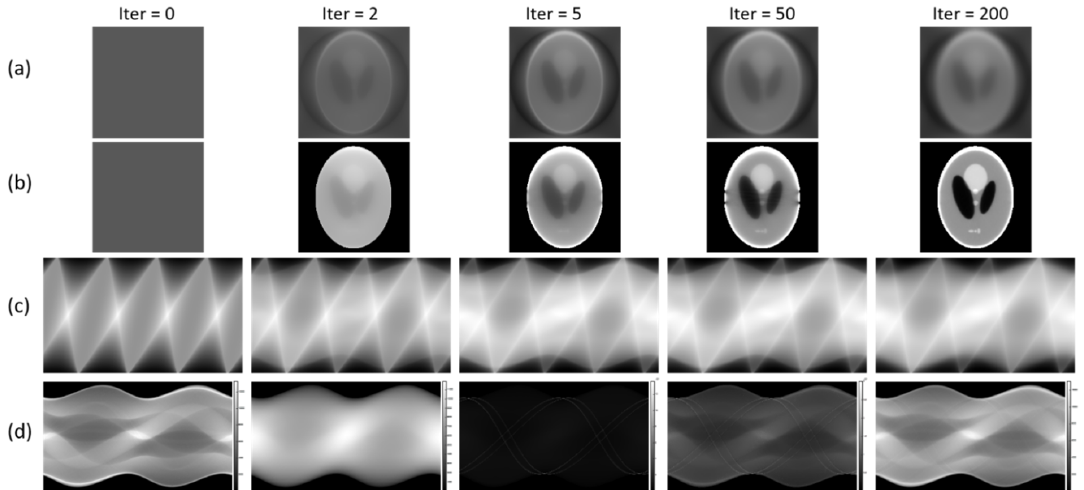
Figure 8. ( a , b ): Reconstructed images at different iterations with uniform initials but different initial variance. ( c , d ): The change of variance ρ 2 at different iterations according to ( a , b ). (b) Effects of Variance Normalization